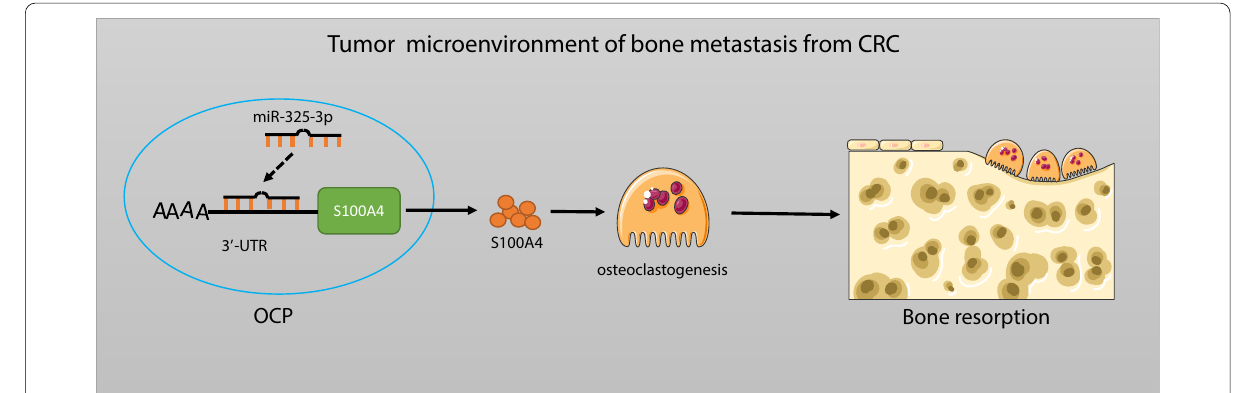
Fig. 6 Schematic of the underlying mechanism of miR-325-3p regulating osteoclastogenesis in metastatic bone of